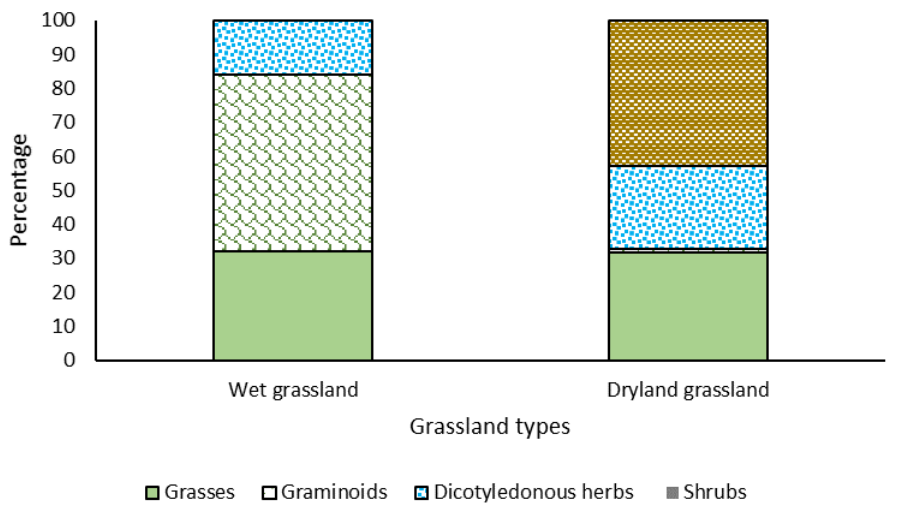
Figure 3. Percentage contribution of the main functional groups of plants to the botanical composi- tion of wet and dryland grasslands present in the study area. Average of two evaluation seasons.